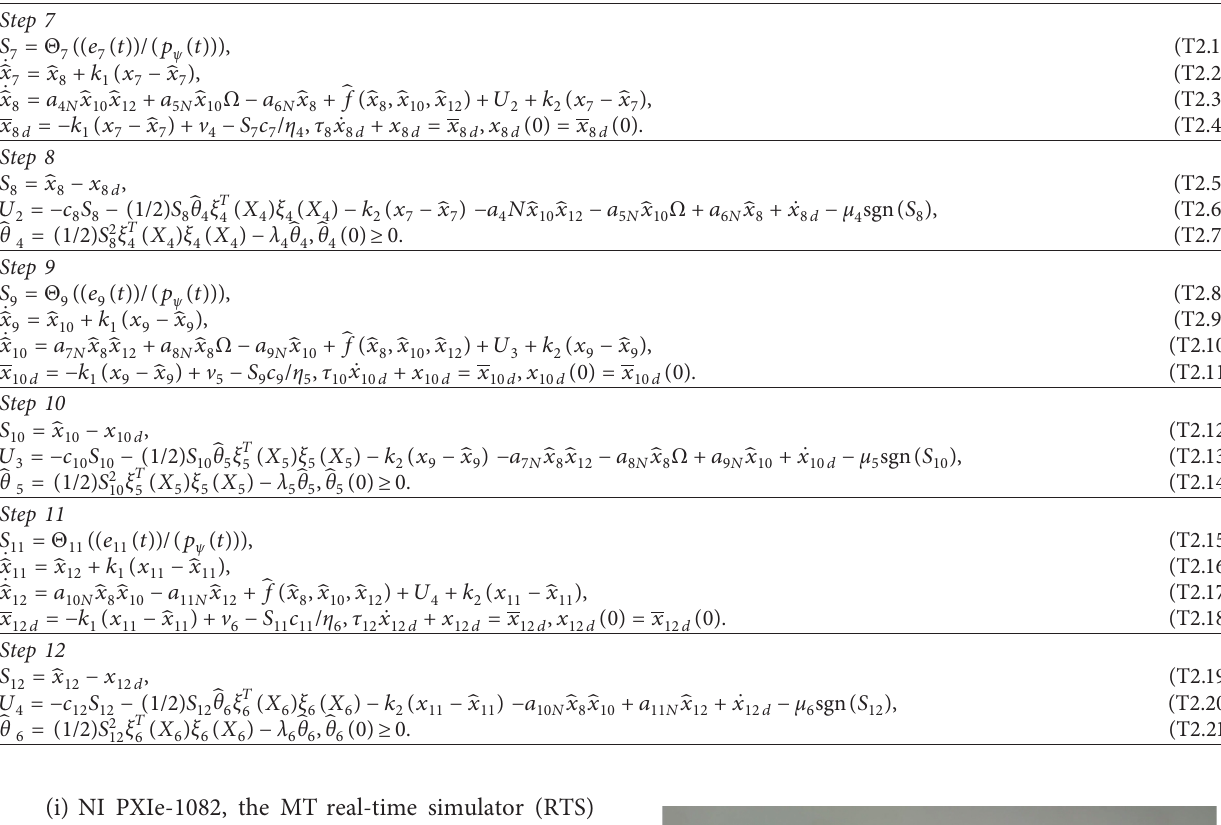
Table 2: The proposed DSCSM design for attitude trajectory control.